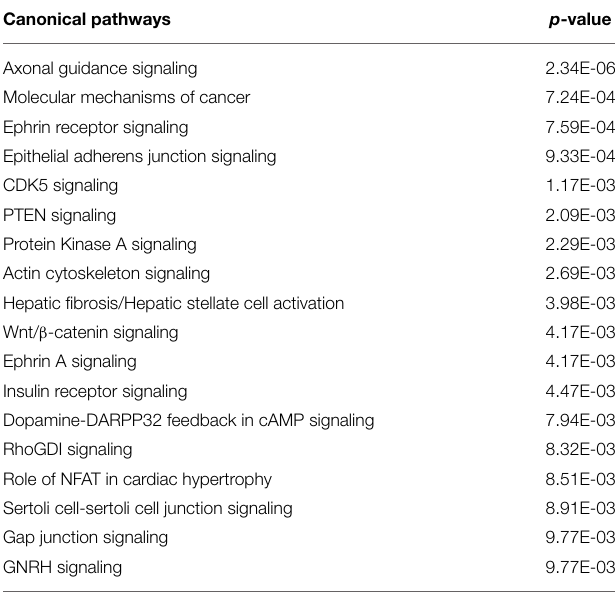
TABLE 7 | Significantly Enriched canonical pathways ( p < 0 . 01 ) between GD90 and GD165 in the choroid plexus. Canonical pathways p